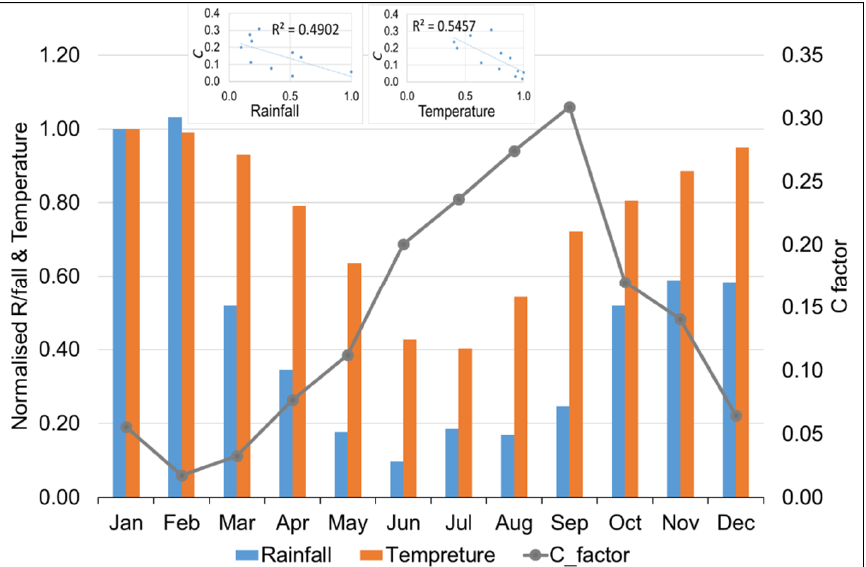
Figure 3. The relationship between normalised rainfall and temperature with C factor; insert linear regression of rainfall, temperature and C factor for 2016–2017. The climate values were normalised by dividing all values by the first value in the distribution (i.e., January).